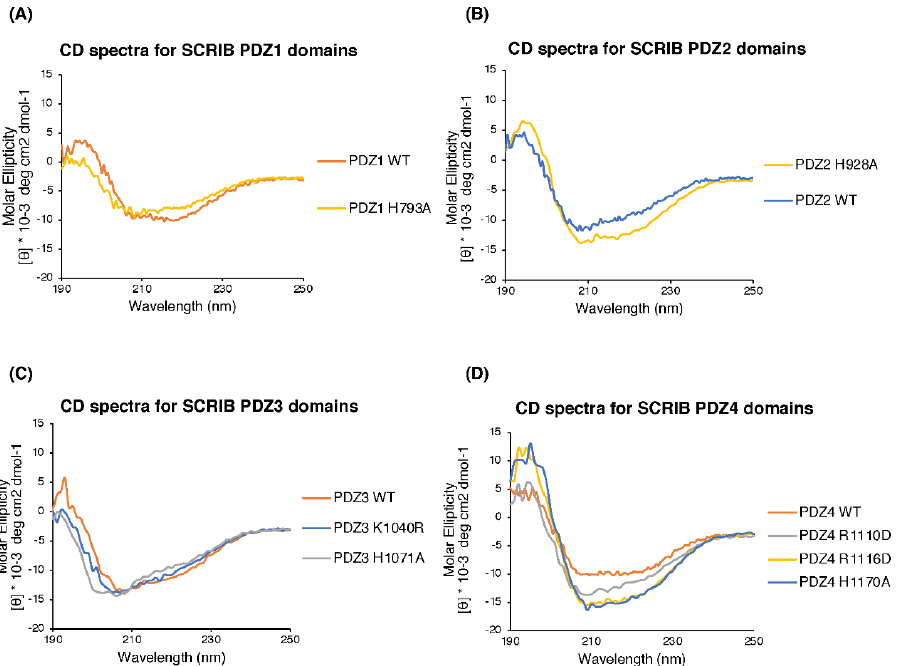
Figure 6. Circular dichroism spectroscopy of wild-type and mutant SCRIB PDZ domains. (A) Spectra for Scrib PDZ1, ( B) spectra for Scrib PDZ2, ( B) spectra for Scrib PDZ3 and ( D) spectra for Scrib PDZ4. Circular dichroism spectra recorded for wild-type and mutant SCRIB PDZ1, 2, 3 and 4 domains indicated that there were no major spectral differences between the proteins, with both wild-type and mutant spectra showing the characteristic features indicative of a fold containing mixed alpha/beta secondary structure elements, suggesting that they were similarly folded, with mutations not leading to unfolding of the PDZ